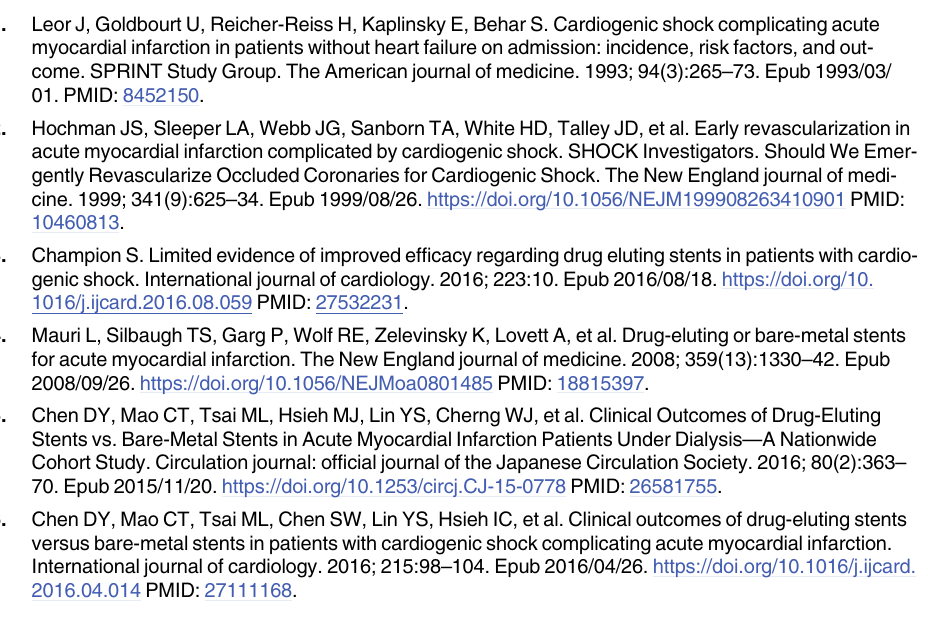
S2 Fig. Effect of stent subtypes on the risk of primary composite outcomes during 1-year follow-up using the sample before propensity score matching. S1 Table. ICD-9-CM diagnostic codes. S2 Table. The baseline comorbidities of the CS-AMI cohort stratified according to being younger or older than 65